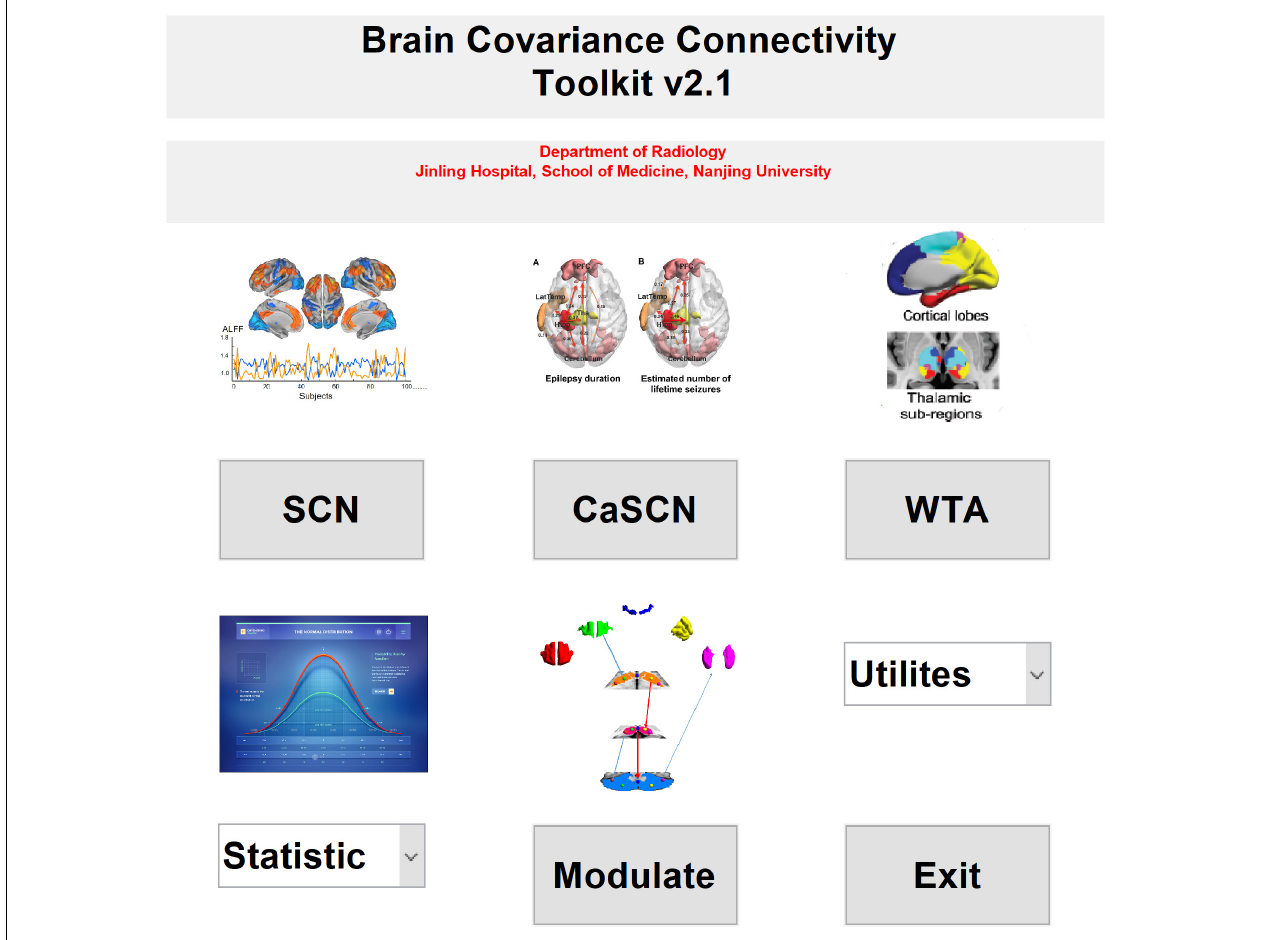
FIGURE 1 | The main interface of the brain covariance connectivity toolkit (BCCT) toolkit. CaSCN, causal analysis of structural covariance network; SCN, structural covariance network; WTA,